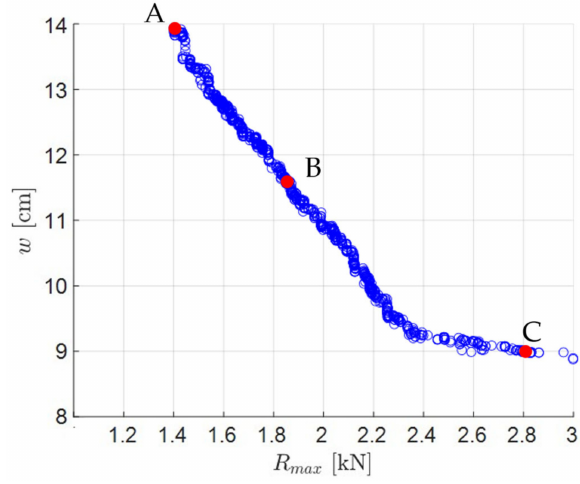
Figure 9. Approximate pareto-front obtained from the optimization study.